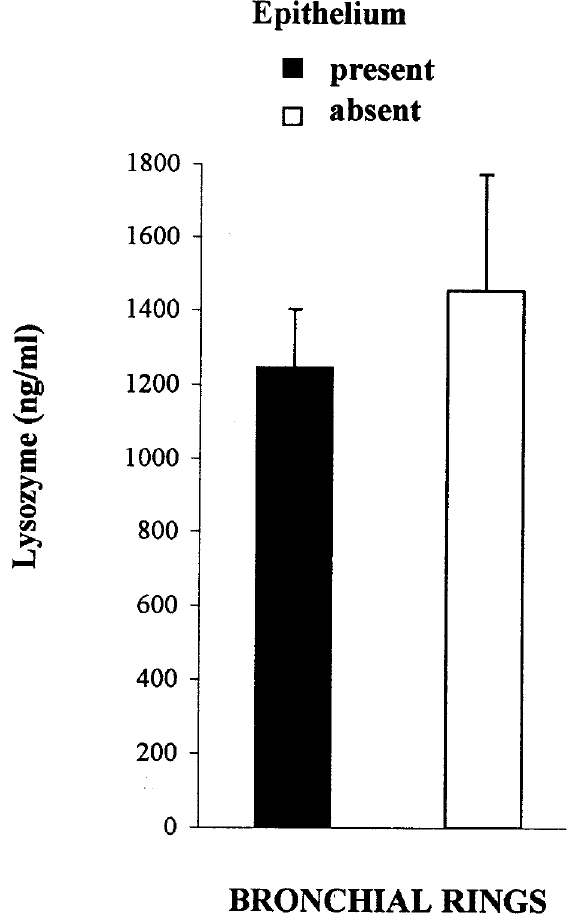
FIG. 3. Lysozyme quantities (ng/ml) contained in fluids derived from human bronchial preparations either with ( j ) or without ( h ) surface epithelium. Values are means±SEM (10–40 bronchial rings from three to six lung samples; mean tissue wet weight: